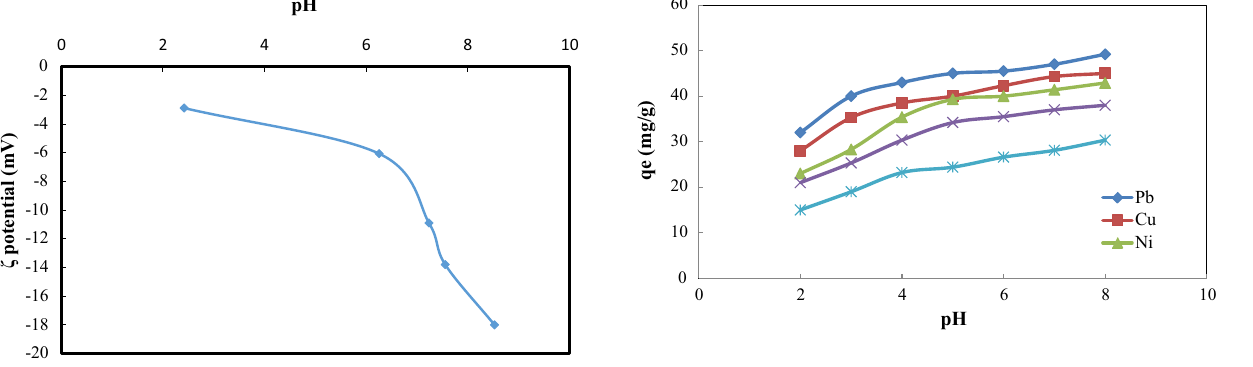
Fig. 1 Zeta potential of Posidonia oceanica at various pH values